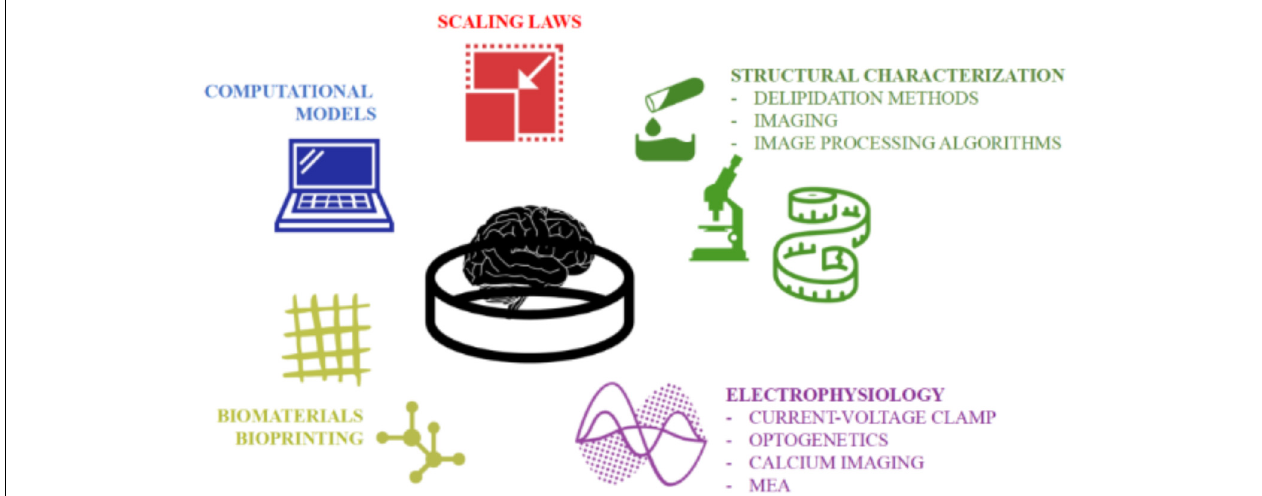
FIGURE 7 | The multidisciplinary tools toward establishing a quantitative and accurate in vitro model of the human brain. An integration of computational and experimental approaches would allow a rigorous structural and functional characterization of the neuronal networks within organoids and their validation as physiologically relevant downscaled in vitro models of the human